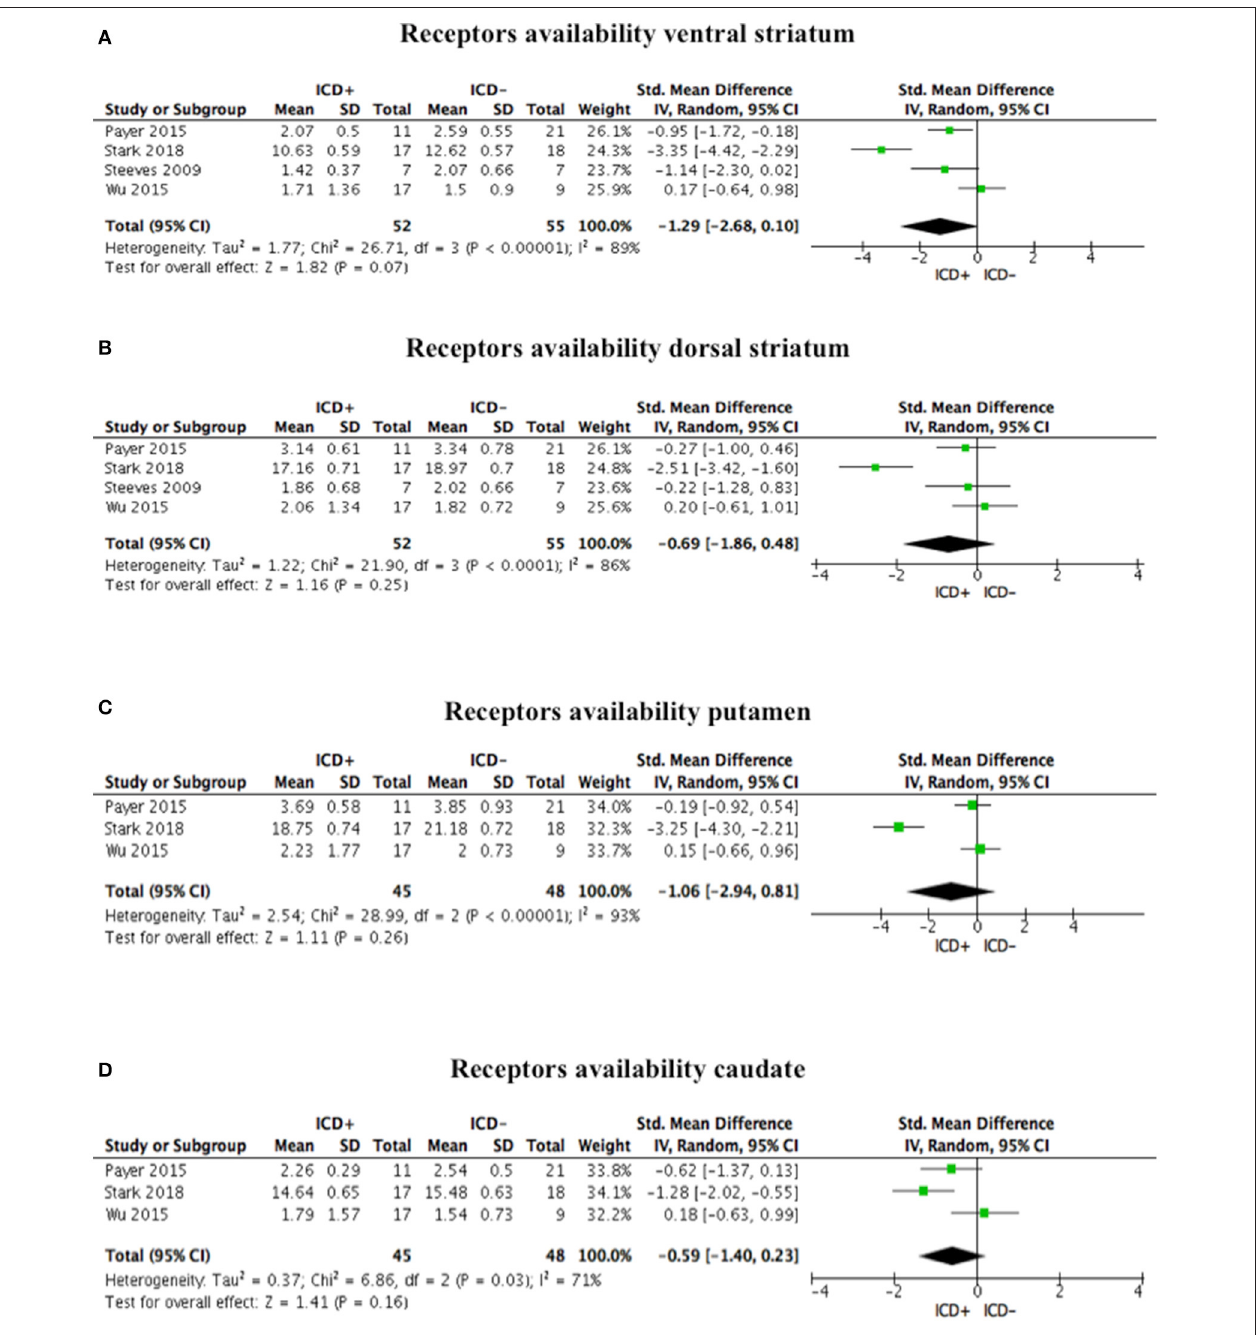
FIGURE 4 | Forest plots for post-synaptic receptors availability. Here are reported forest plots for post-synaptic receptors availability in the ventral striatum (A) , dorsal striatum (B) , putamen (C) , and caudate (D) . Standardized mean difference represents Hedges’s g effect size. The size of the square indicates the weight of the study. The horizontal line represents the 95% confidence interval. The diamond represents the pooled effect size. Negative effect sizes indicate lower receptors availability in PD patients with ICD (ICD + ) in comparison to those without ICD (ICD–). ICD, impulse control disorder; PD, Parkinson’s disease.